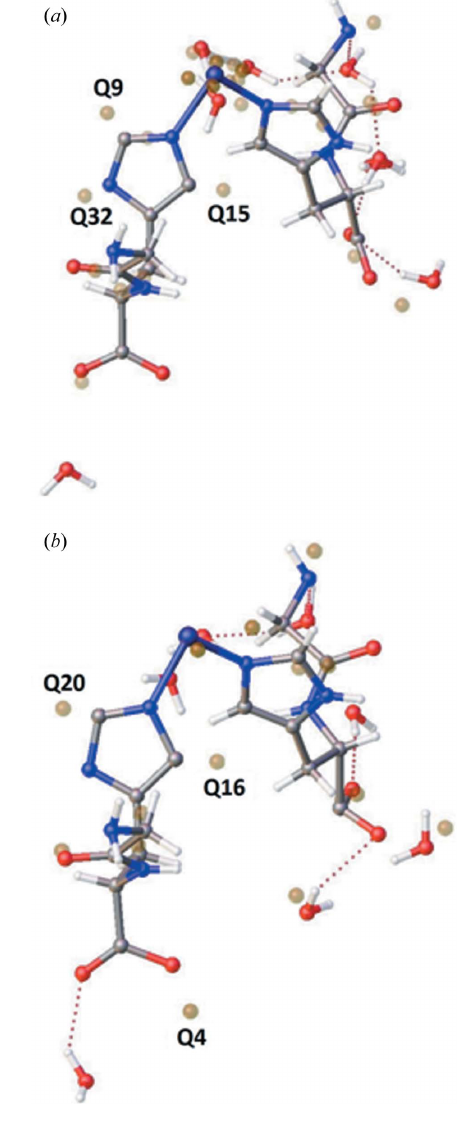
Figure 5 Residual density plots based on data from ( a ) the first scan, i.e. 0.63 MGy, and from ( b ) the 12th scan, i.e. 7.56 MGy. Carbon is shown in grey, nitrogen is shown in blue, oxygen is shown in red, hydrogen is shown in white and nickel is shown in dark blue/purple. Residual peaks are coloured brown and the numbered Q labels refer to a ranked peak height. Values for residuals in hydrogen positions are 0.48–0.63 e A˚ 3 and 0.31– 0.40 e A˚ 3 for structures shown in ( a ) and ( b ),